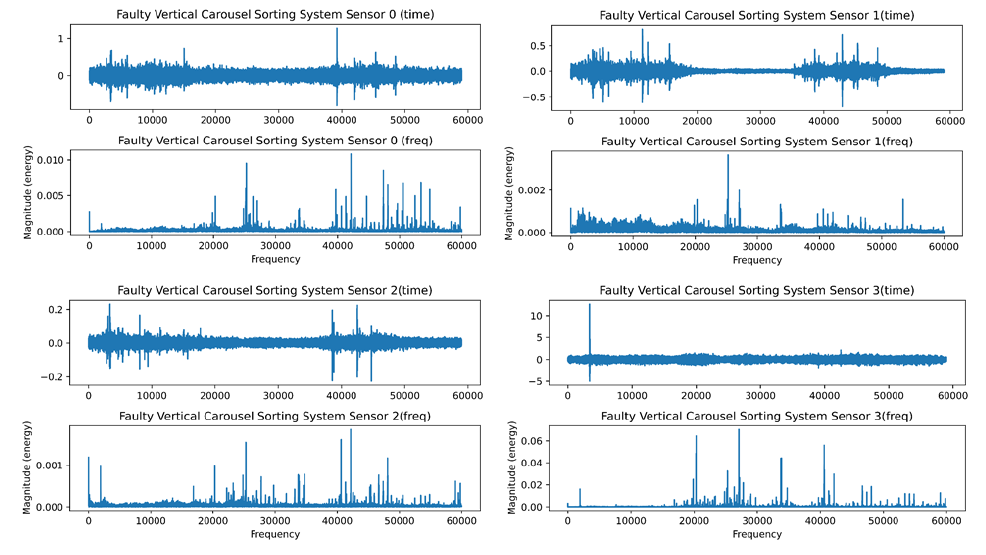
Figure 8. The faulty time and frequency analysis for the VCSRS vibration data.